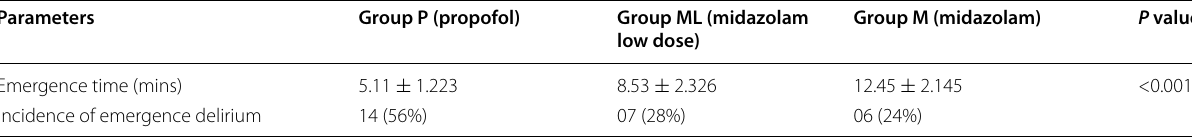
Values are presented as mean SD, number of patients (%), * p value <0.05 statistically ±